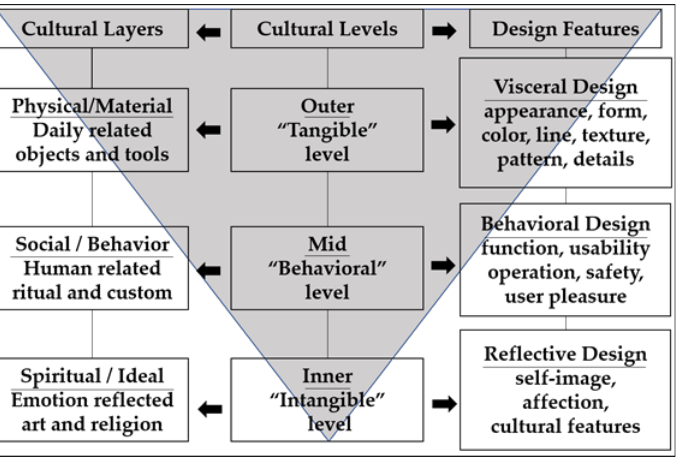
Figure 2. The three layers and levels of cultural objects and design features. Adapted with permission from Ref. [14]. 2007, Rung-Tai Lin.